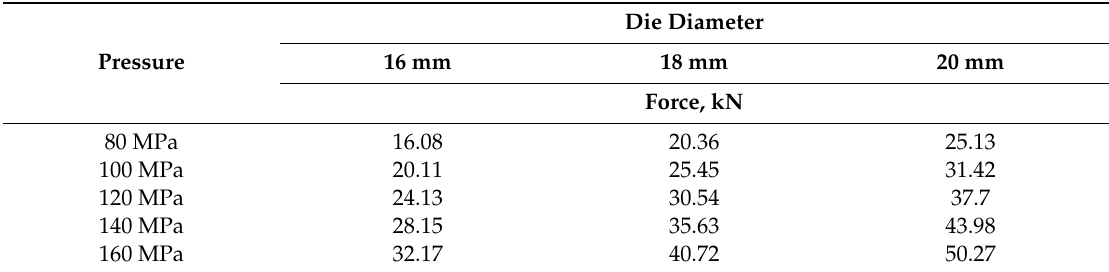
Table 1. Compaction pressure levels with forces for di ff erent die